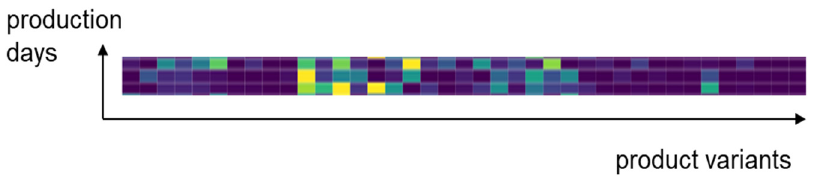
Figure 10. Experimental setup of detailed analysis.